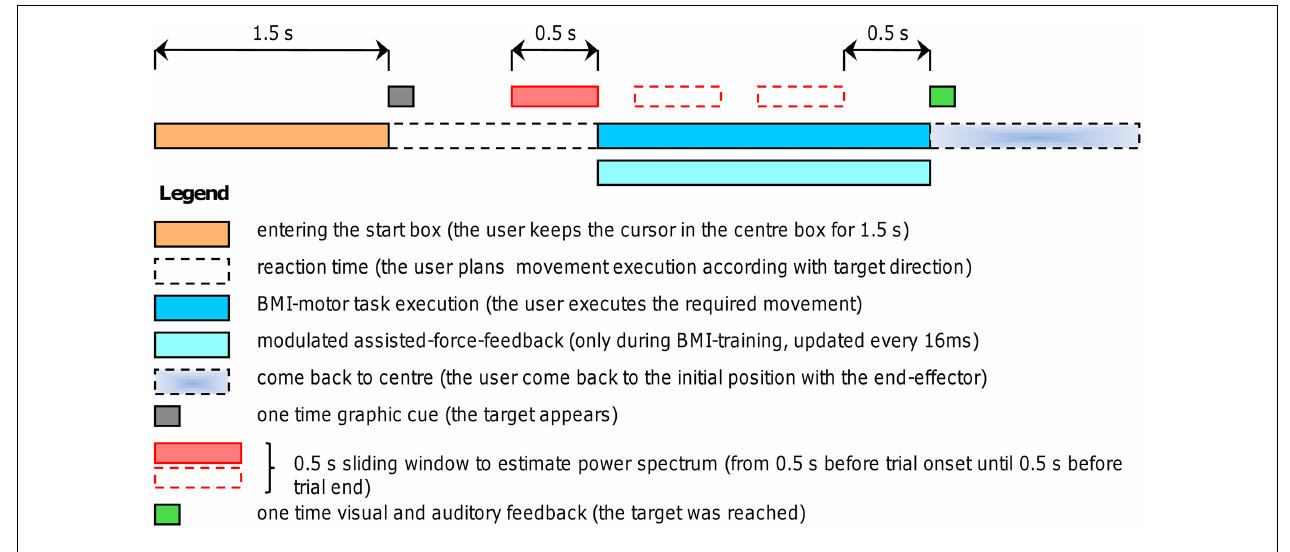
toward the target; as soon as the target was reached (i.e., at the end of the trial) both visual and auditory feedback inform the user about the task completion; then the user comes back to the center position to start another trial. During BMI-training an assisted-force-feedback was provided according to the algorithm explained in Section “On-Line BMI Assisted-Force-Feedback.”